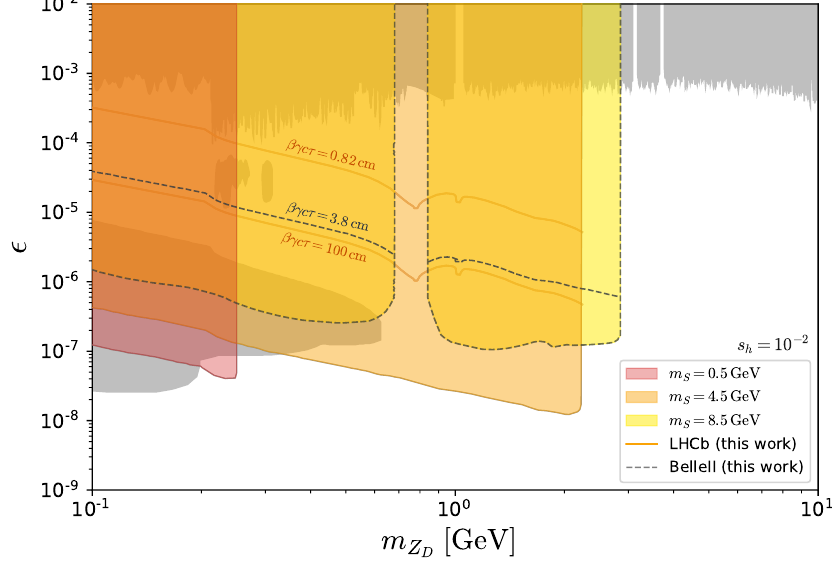
Figure 6 . Expected sensitivity in the m Z × (cid:15) parameter space for the LHCb (solid) and Belle D II (dashed) searches. The colors represent different dark photon mass choices, as indicated by the labels. The dashed black line crossing Belle II bound indicates where the dark photon decay length reaches 3 . 8 cm , which is the distance at which it enters the vertex detector, such that the signal can be recognized as displaced. Similarly, we indicate with the upper solid orange line the distance of the LHCb vertex discriminator. The lower solid line denotes the distance at which the dark photons exit the vertex detector of LHCb. Gray bounds represent the same dark photon exclusion limits as described in figure